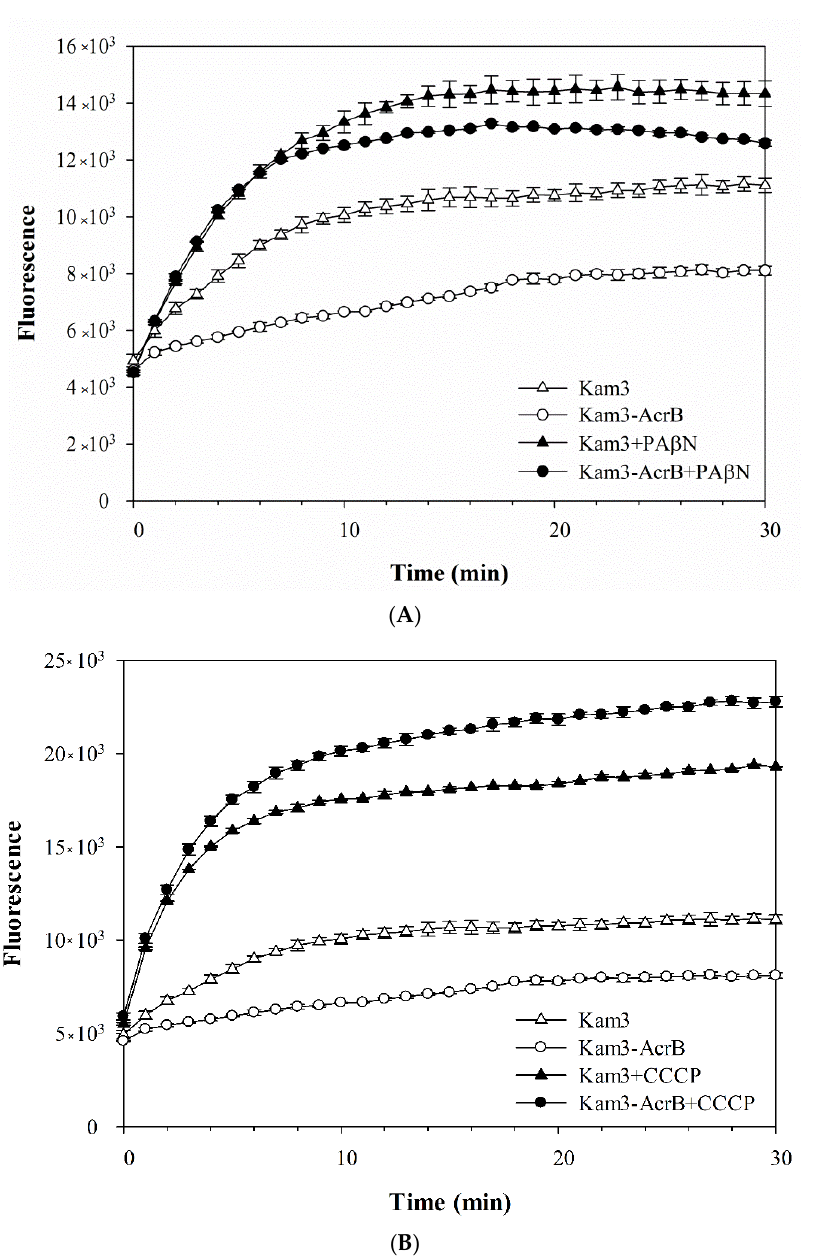
Figure 2. EtBr accumulation in E. coli Kam3-AcrB and Kam3 in the presence of efflux pump inhibitor ( A ) PAβN , ( B ) CCCP. The fluorescence was recorded at excitation and emission wavelengths 520 and 600 nm, respectively, over a 30 min incubation period. Values are expressed as mean ± standard deviation (SD) ( n = 3).